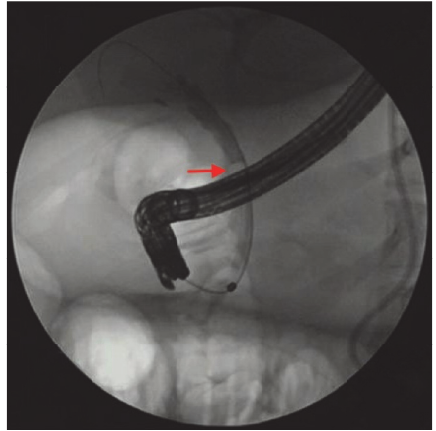
Figure 1: Preintervention MRCP revealing a fluid collection in continuity with the cystic duct representative of a contained bile leak (marked with arrow).